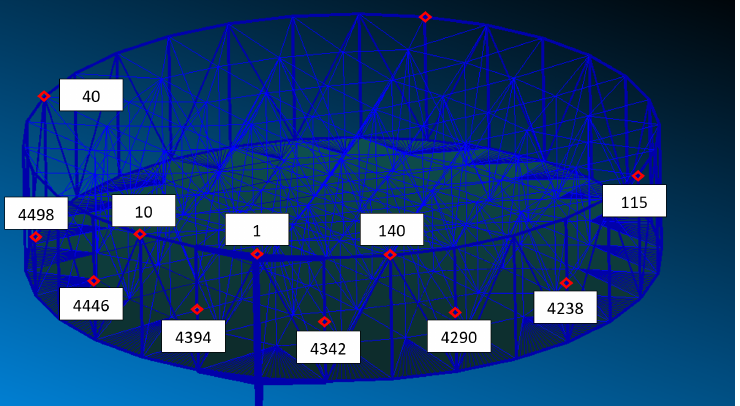
Figure 4. Network of distributed sensors (labels are used to identify the node on which the sensor is